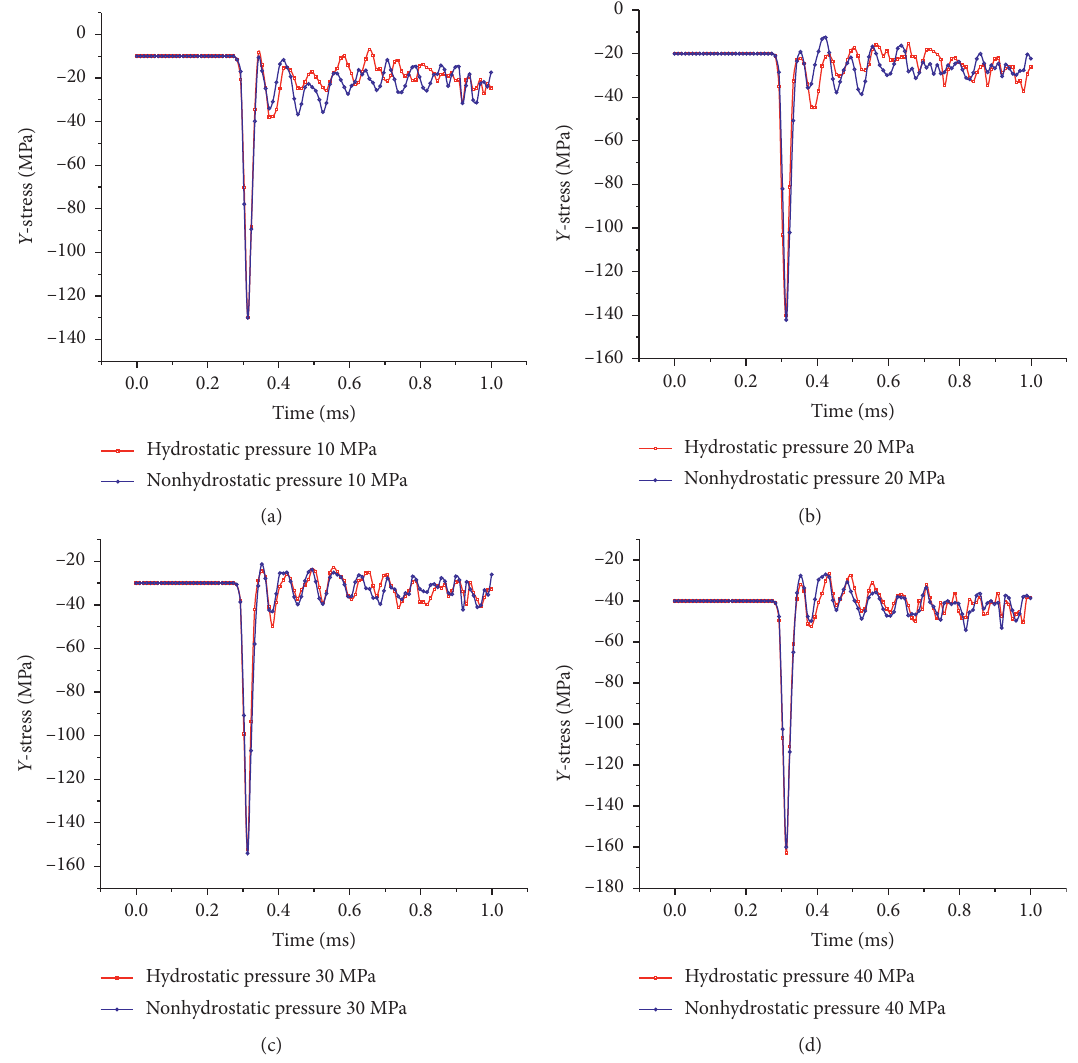
Figure 15: Comparisons of the Y -stress time-history curves at point A between the situations of hydrostatic pressure ( σ nonhydrostatic pressure ( σ x � 50MPa, K d � 2.0): (a) σ y � 10MPa; (b) σ y � 20 MPa; (c) σ y � 30 MPa; (d) σ y �